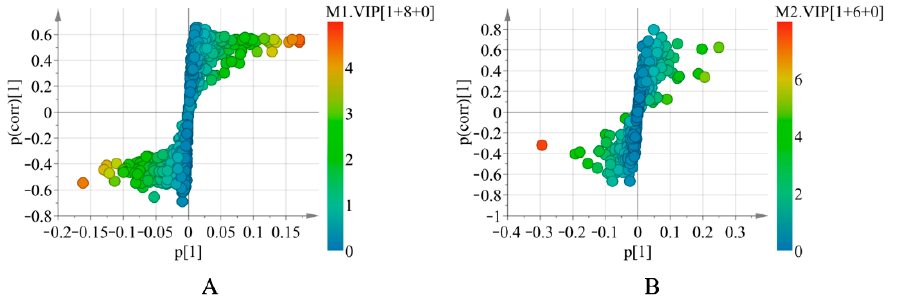
Figure 3. The OPLS-DA S-plots of S. tetrandra by GC-MS analysis ( A ) and UHPLC-Q-TOF-MS/MS analysis in positive ion mode ( B ).